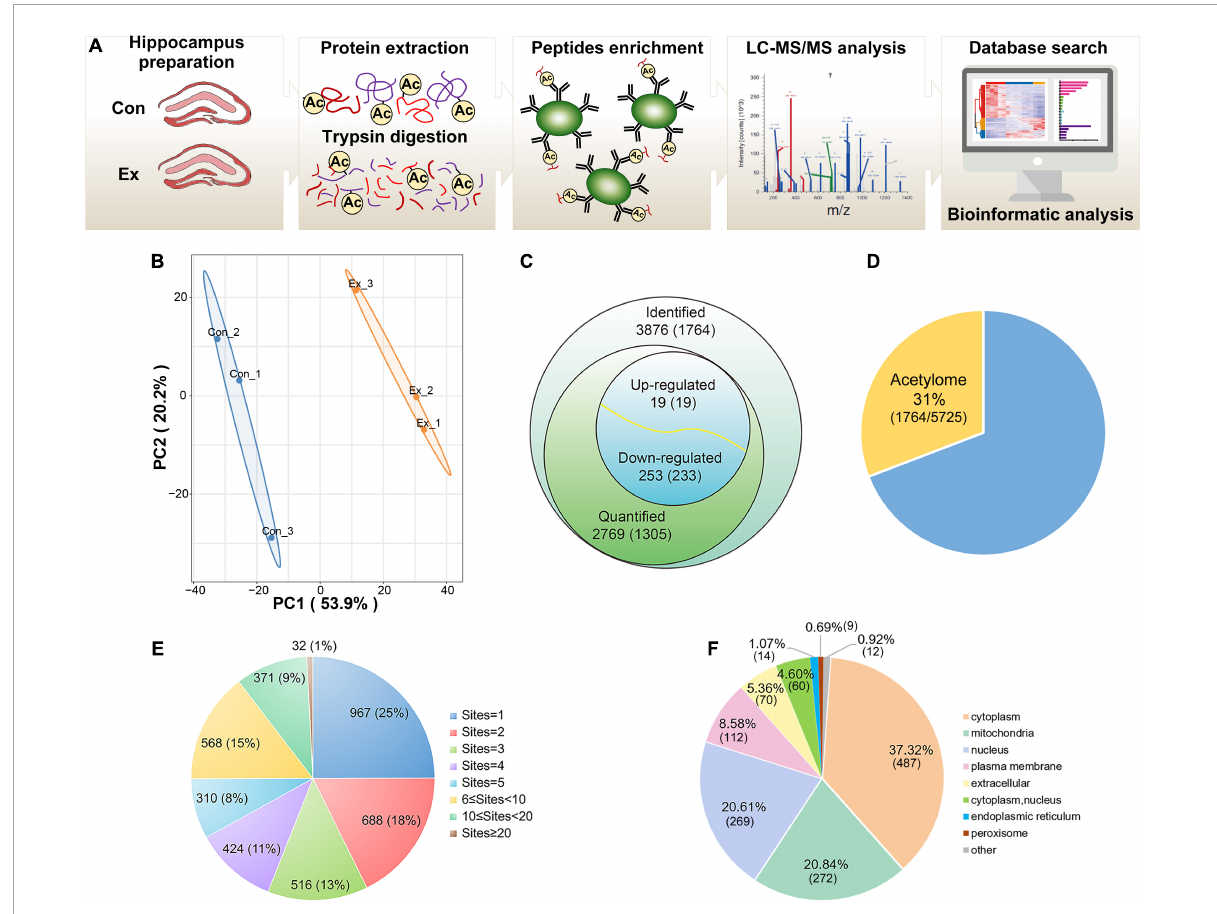
FIGURE2 Profiling lysine acetylation proteome in hippocampus. (A) Mass spectrometry workflow for identification and quantitation of lysine acetylation in the hippocampus. (B) Principal component analysis of acetylome data to distinguish the Ex from the Con. Three biological replicates (bilateral hippocampus from every two mice as one replicate) were performed in each group. (C) Global view of acetylated proteins and acetyl sites. Venn diagram showed the number of acetyl sites and the corresponding proteins in brackets. Acetyl sites with a fold change greater than 1.5 or less than 0.667 and with p -values < 0.05 were considered as significantly upregulated or downregulated. (D) The relative ratio of acetylated proteins identified in the acetylome to proteins identified in the proteome. (E) Distribution of the acetyl site occupancy per protein. (F) Subcellular distribution predicted for all the quantified acetylated proteins. LC–MS/MS, liquid chromatography-tandem mass spectrometry; PCA, principal component